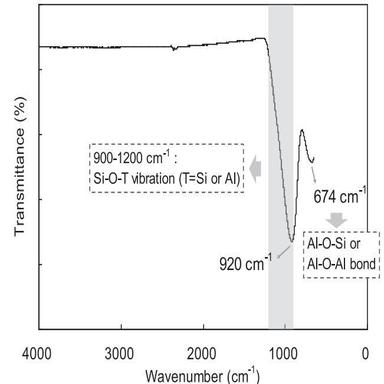
FT-IR spectrum of the IGCC slag sample. The primary band was observed at approximately 920 cm1 , indicating the presence of the Si-O-T (T = Si or Al) vibration with a high Al/Si ratio.